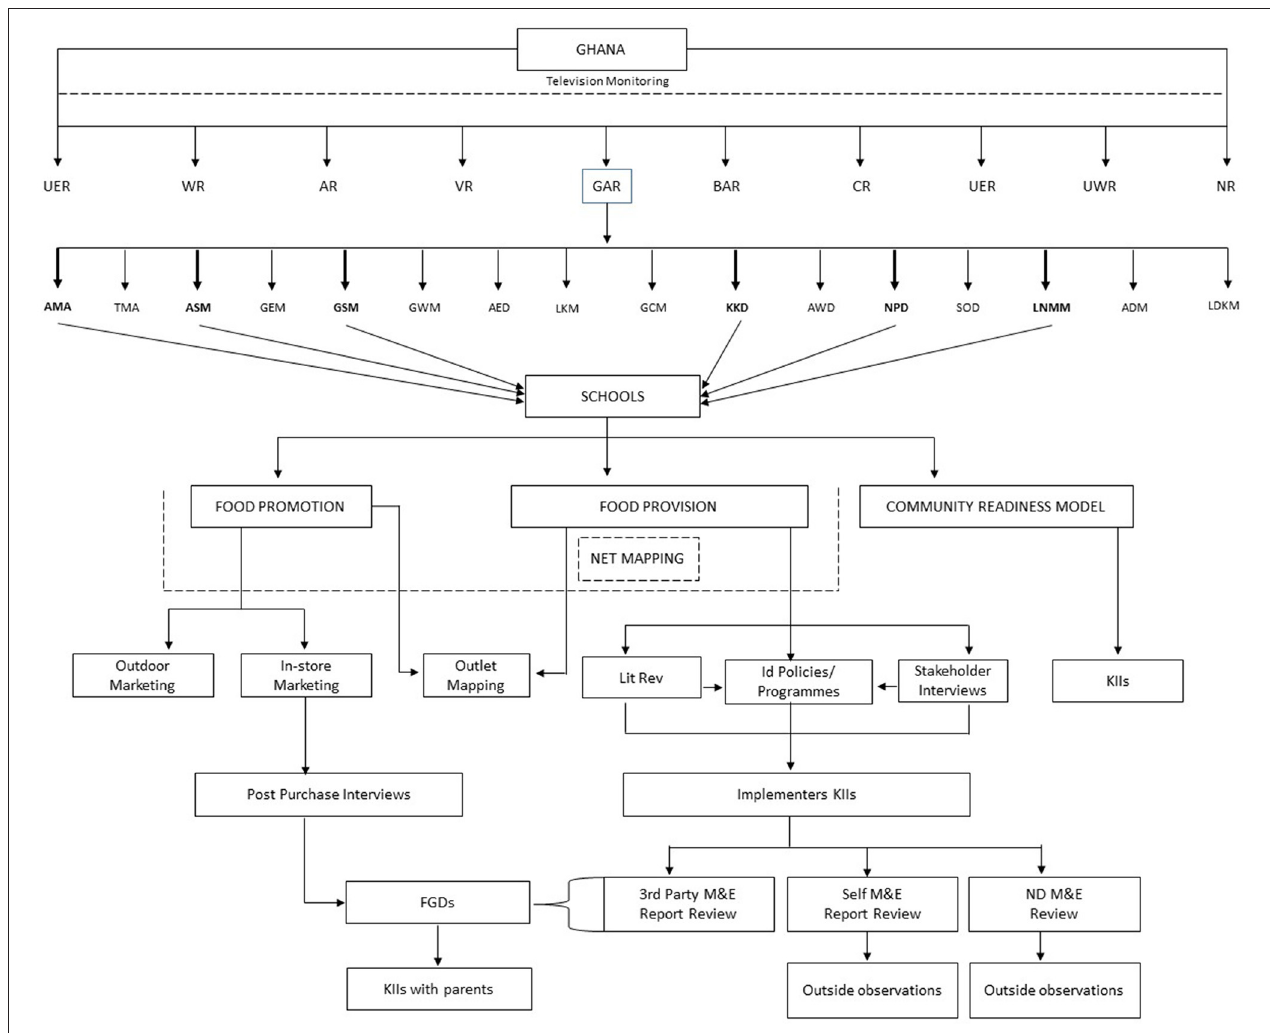
FIGURE 2 | Overall study organization and sampling schema. AED, Ada East District, ADM, Adentan Municipality; AMA, Accra Metropolitan Assembly; AR, Ashanti Region; ASM, Ashaiman Municipality; AWD, Ada West District; BAR, Brong Ahafo region; CR, Central Region; ER, Eastern Region; GCM, Ga Central Municipality; GEM, Ga East Municipality; Ga South Municipality; Ga West Municipality; GAR, Greater Accra Region; KKD, Kpone- Katamanso District; La Dade Kotopon Municipality; La Nkwantanang-Madina Municipality; LKM, Ledzokuku-Krowor Municipality; NPD, Ningo Prampram District; NR, Northern Region; Shai Doku